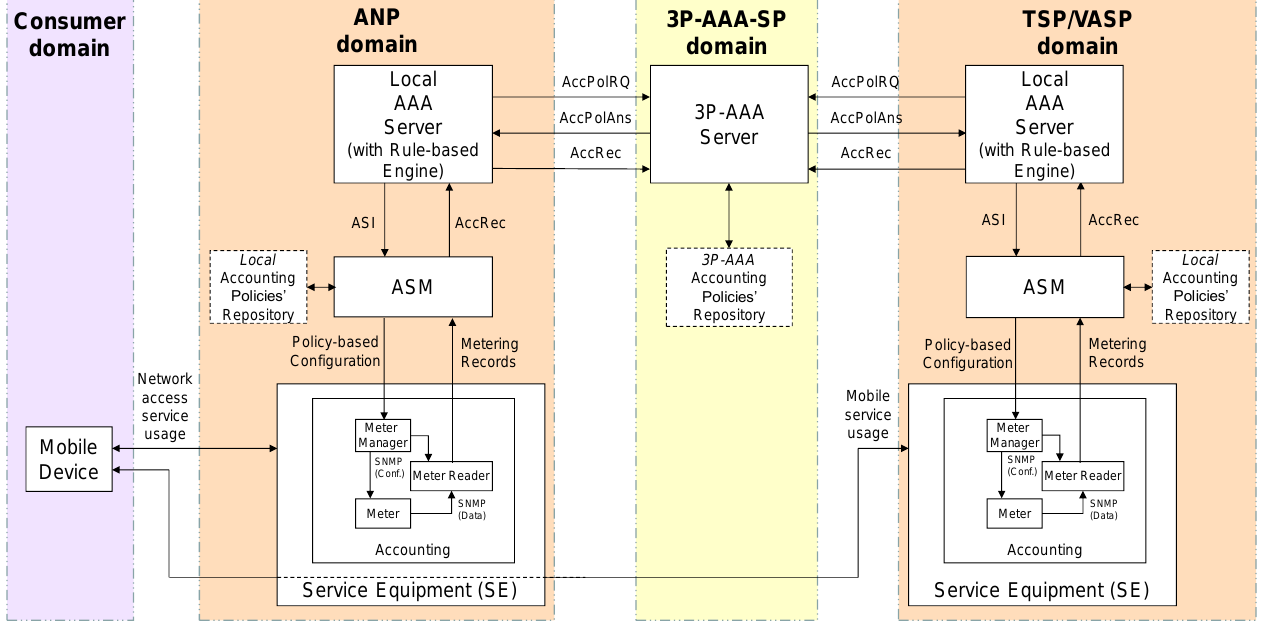
Figure 5. An example illustrating the signaling and message exchange sequence across relevant in- ter-domain interfaces for the pull authorization model for the 3P-AAA provision (an update from [21]).